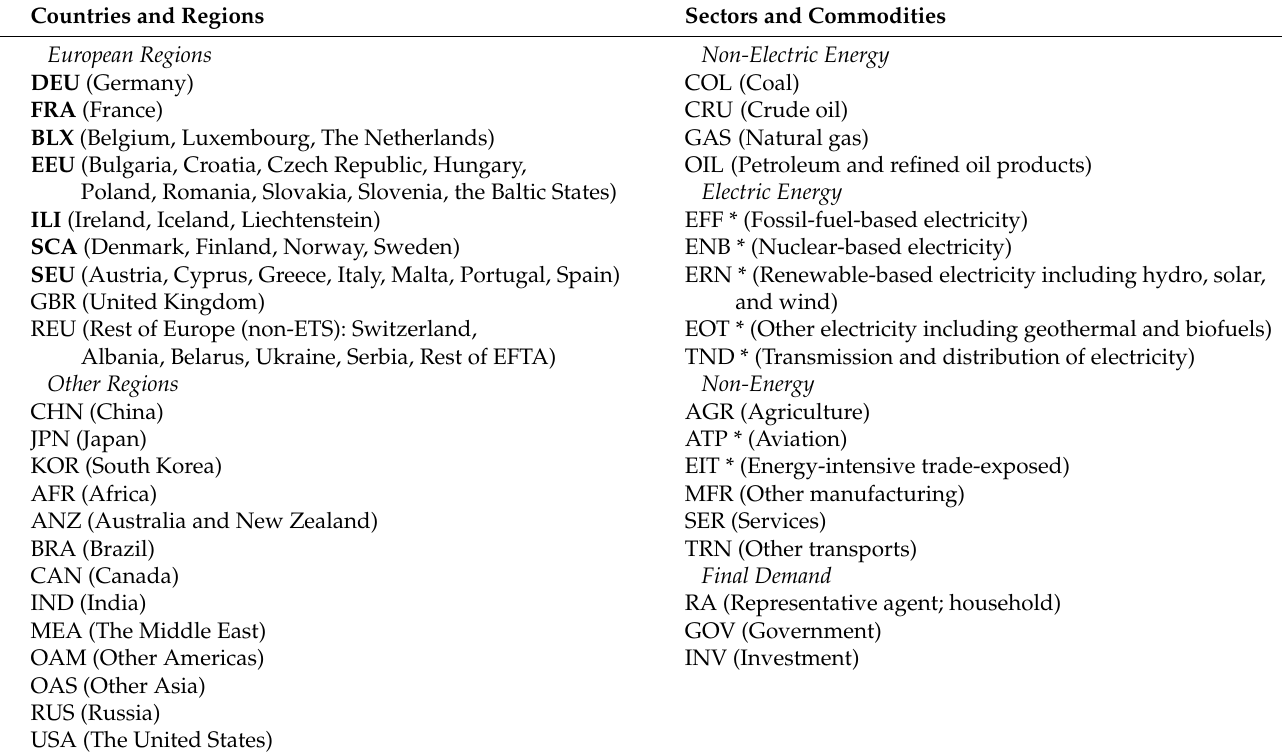
Table 2. Model regions and